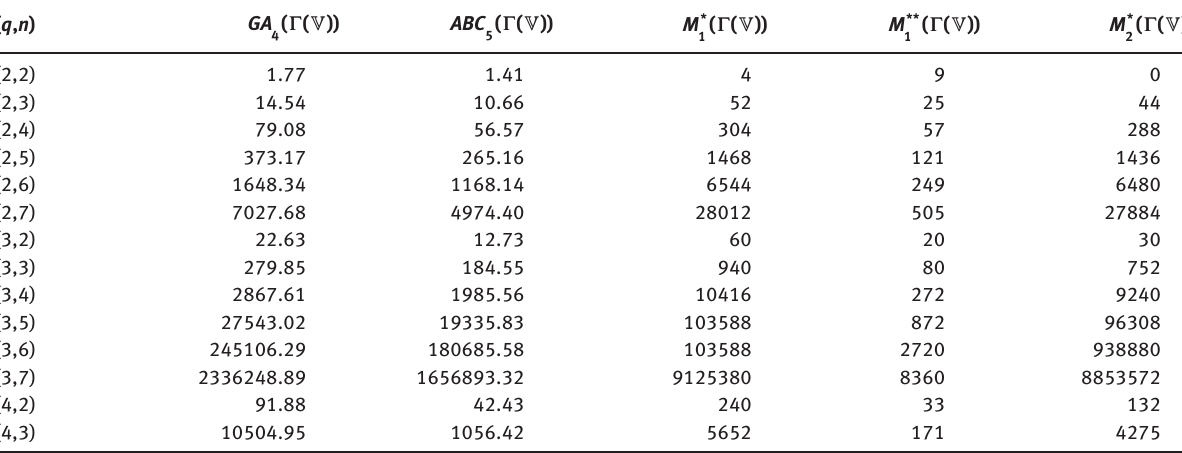
Table 3: Numeric comparison of the investigated indices at certain values of q and n